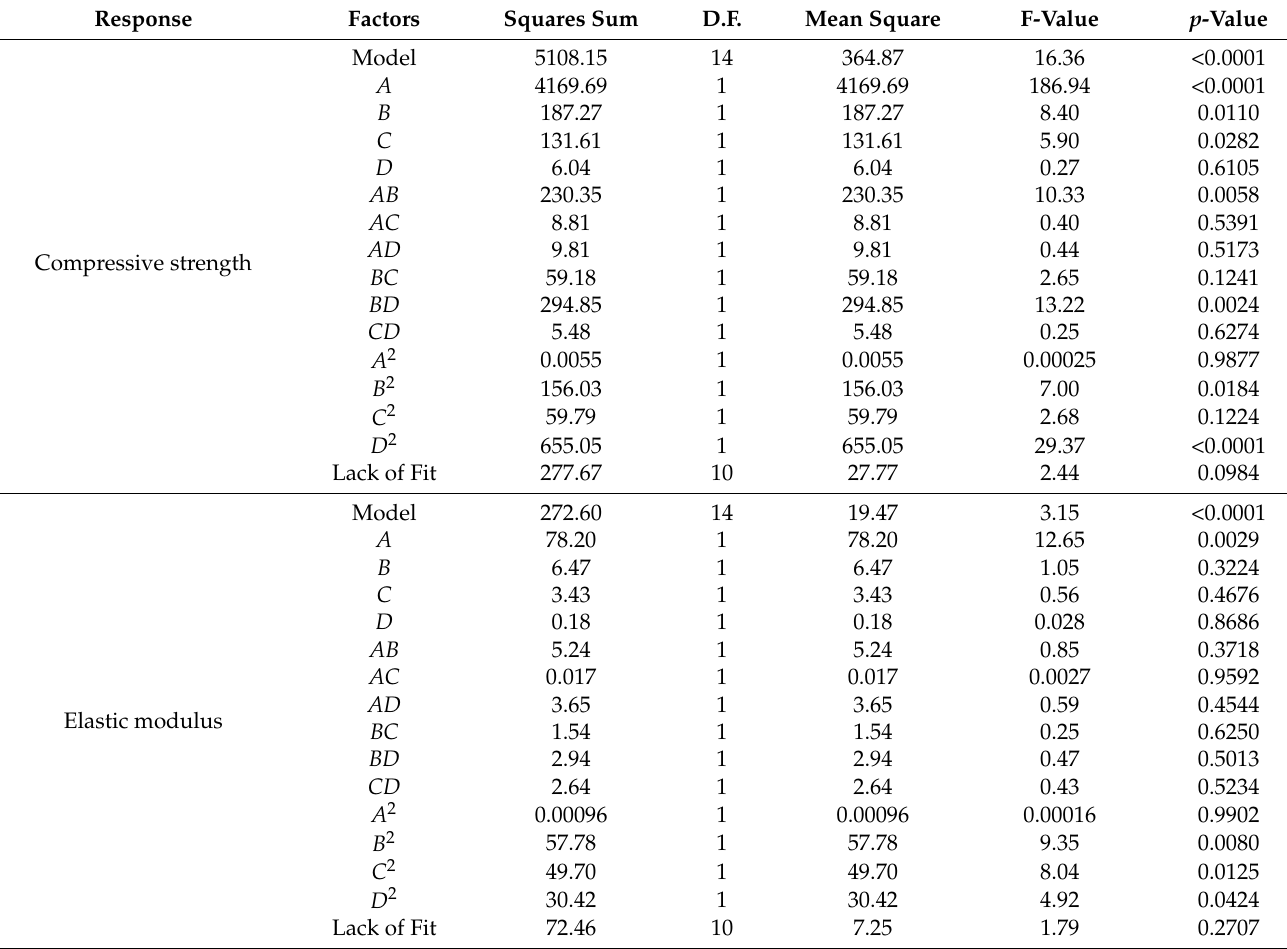
Table 6. ANOVA for the developed response